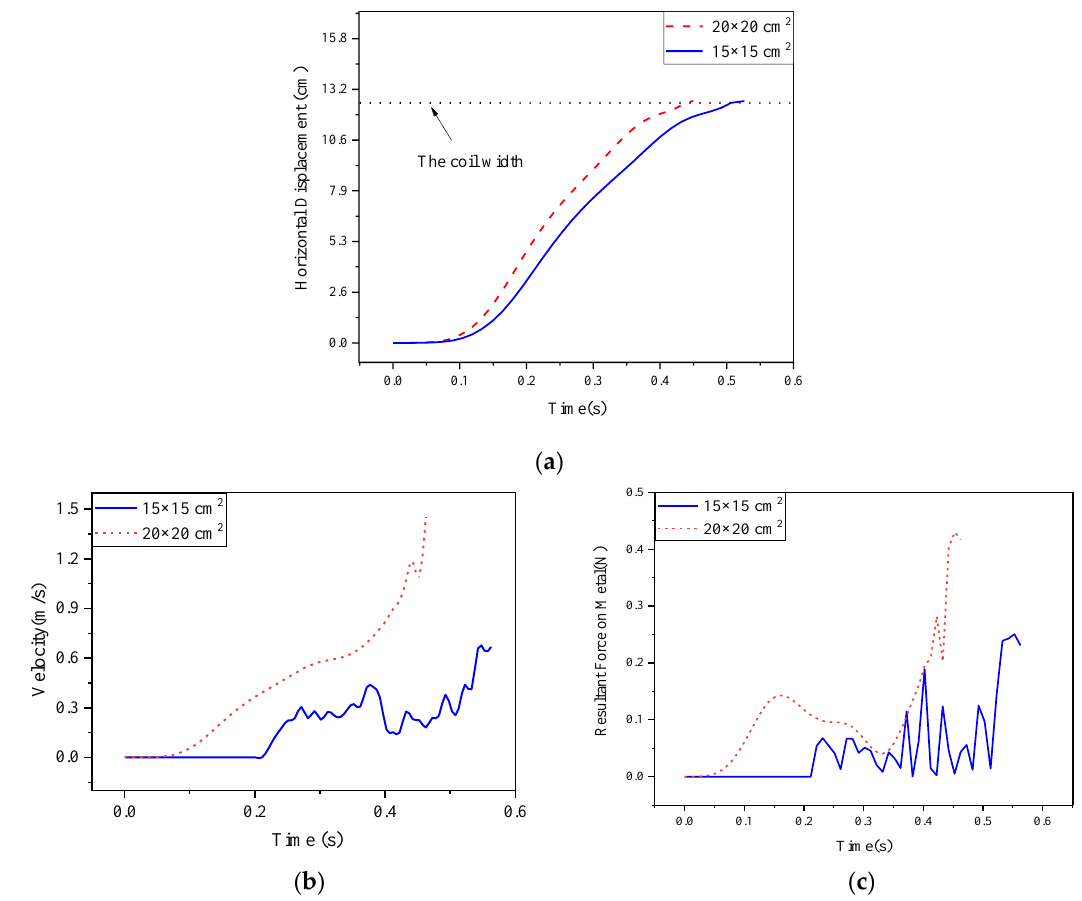
Figure 11. Horizontal displacement, velocity and resultant force changes when aluminum flies out. ( a ) Horizontal displacement; ( b ) velocity; ( c ) resultant force.